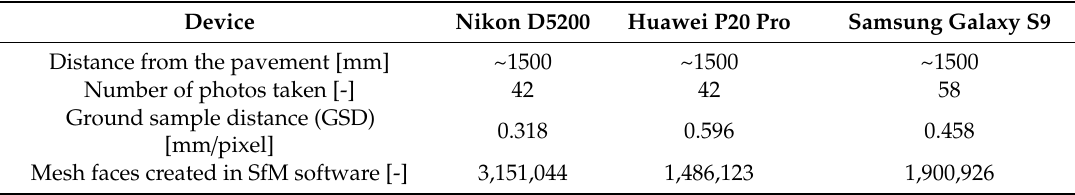
Table 4. Survey specifications for distress 3.